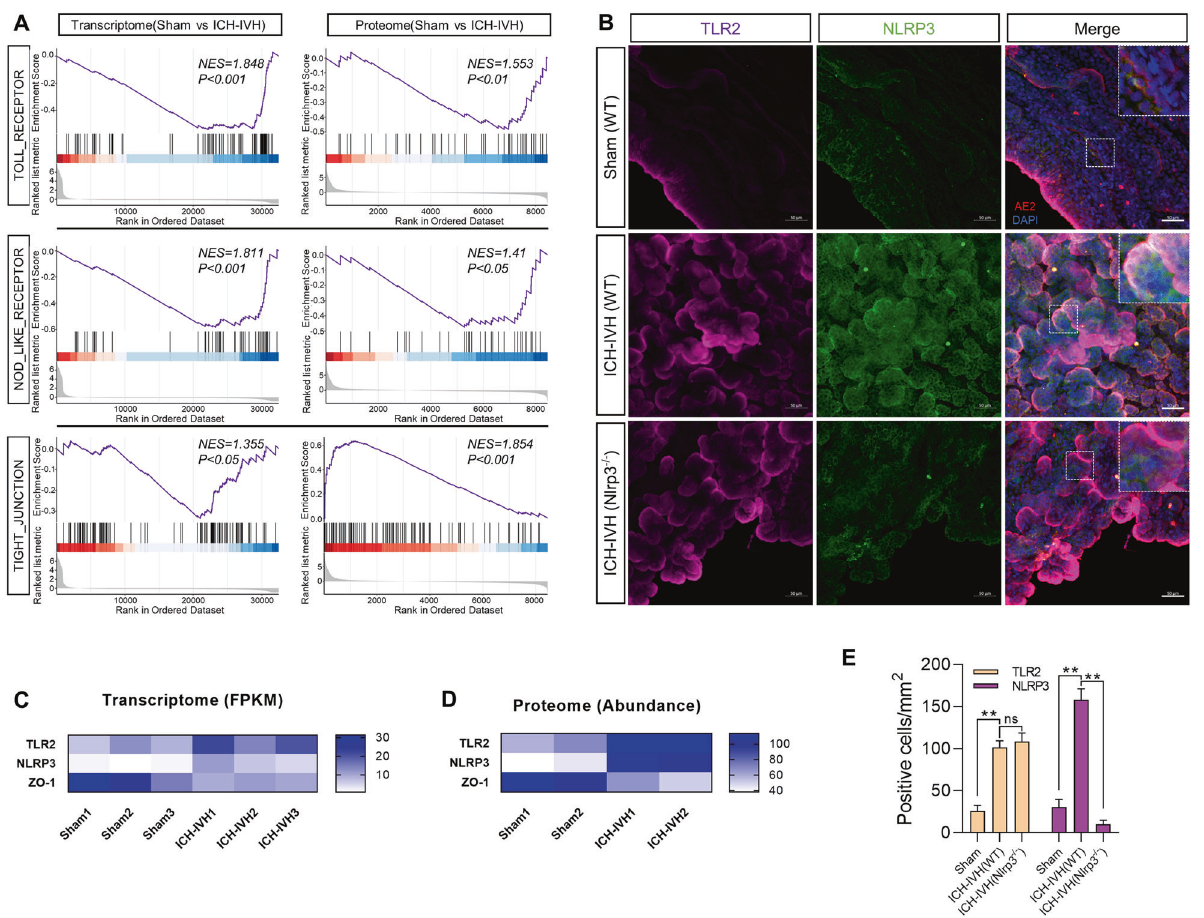
Fig. 2 Choroid plexus sequencing results con fi rmed that TLR2/NLRP3 pathway activation and tight junctions were abolished at 3 days after ICH-IVH. A GSEA enrichment plots demonstrating the degree of correlation between genes in the Toll receptor-, NOD-like receptor-, and tight-junction-associated categories and proteins in choroid plexus tissues from the control and ICH-IVH groups. B Immuno fl uorescent staining images of TLR2 and NLRP3 in the choroid plexus. Scale bar = 50 μ m. C Representative gene abundance heatmap of transcriptome sequencing: TLR2, NLRP3, ZO-1. D Heatmap of proteins screened after proteomic sequencing GSEA enrichment analysis: TLR2, NLRP3, ZO-1. E Analysis of TLR2- and NLRP3-positive cell counting results of choroid plexus immuno fl uorescence staining ( n = 3, one-way ANOVA). The results are expressed as the mean ± SD, ** P < 0.01, ns P >